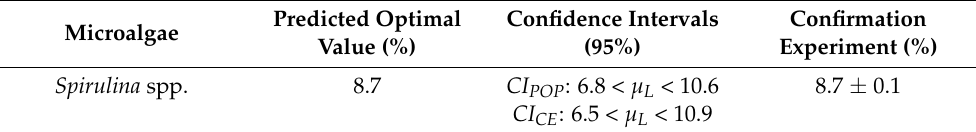
Table 3. Predicted optimal lipid content and the results of confirmation experiment. Predicted Optimal Confidence Microalgae Value (%)